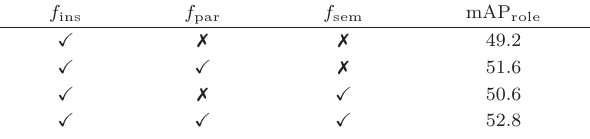
Contribution of different levels of pairwise features to performance, for the V-COCO dataset